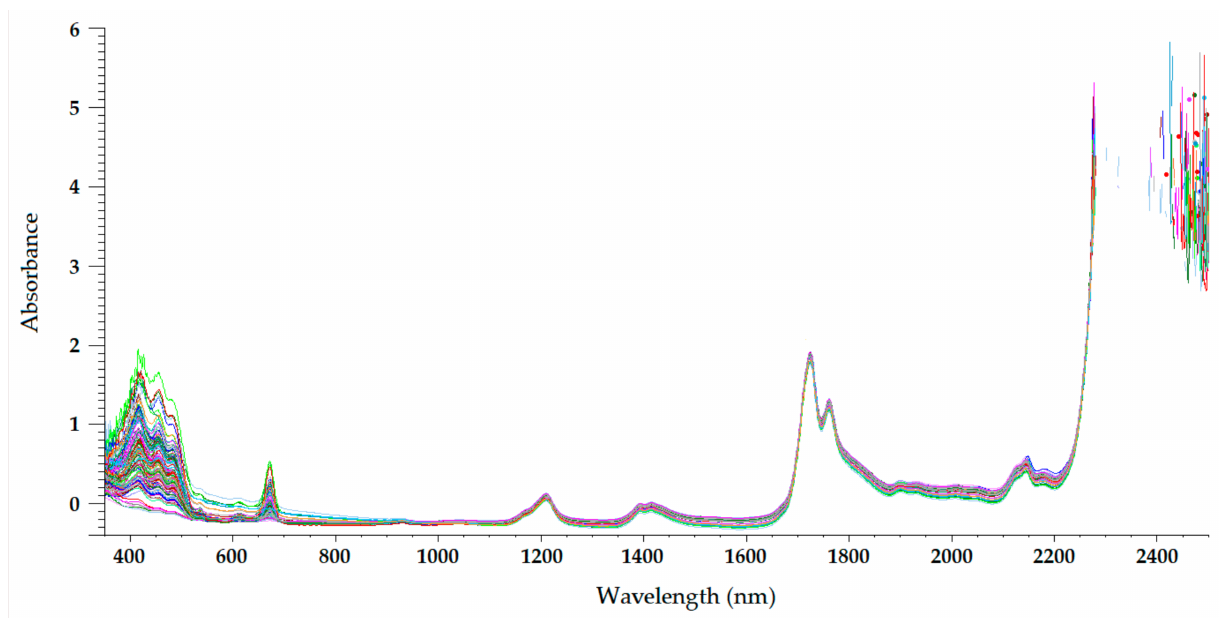
Figure 5. Mean-normalized visible/NIR spectra of 127 olive oils obtained with 5-mm path-length quartz cuvettes [22].